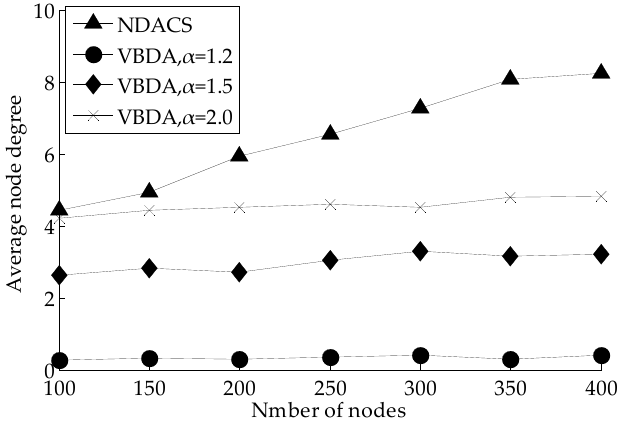
Figure 12. Comparison of average node degree between NDACS and VBDA.